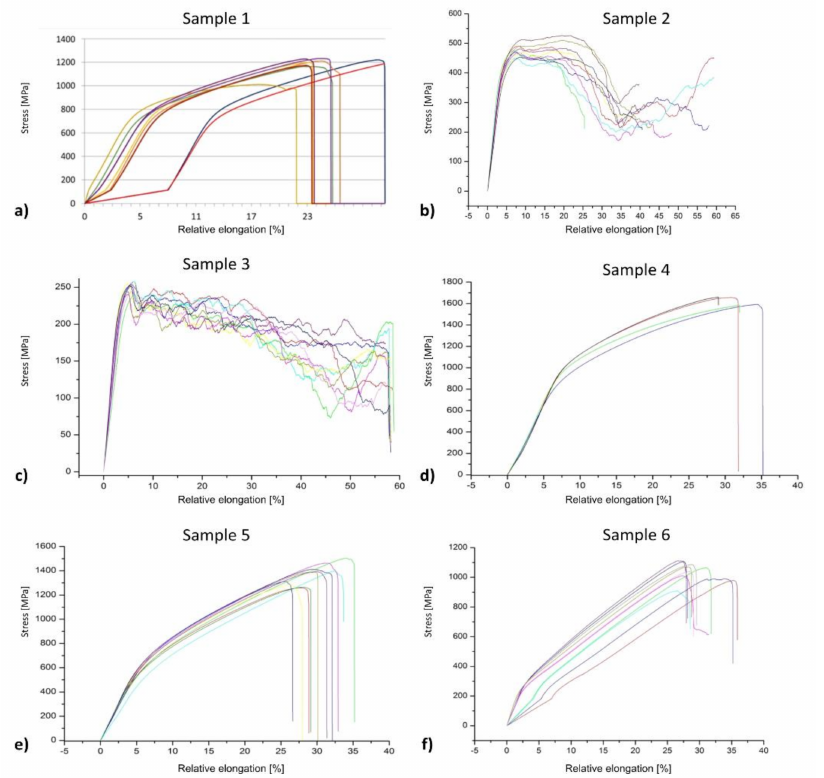
Figure 11. Pressure testing diagram of ( a ) sample 1, ( b ) sample 2, ( c ) sample 3, ( d ) sample 4, ( e ) sample 5, ( f ) sample